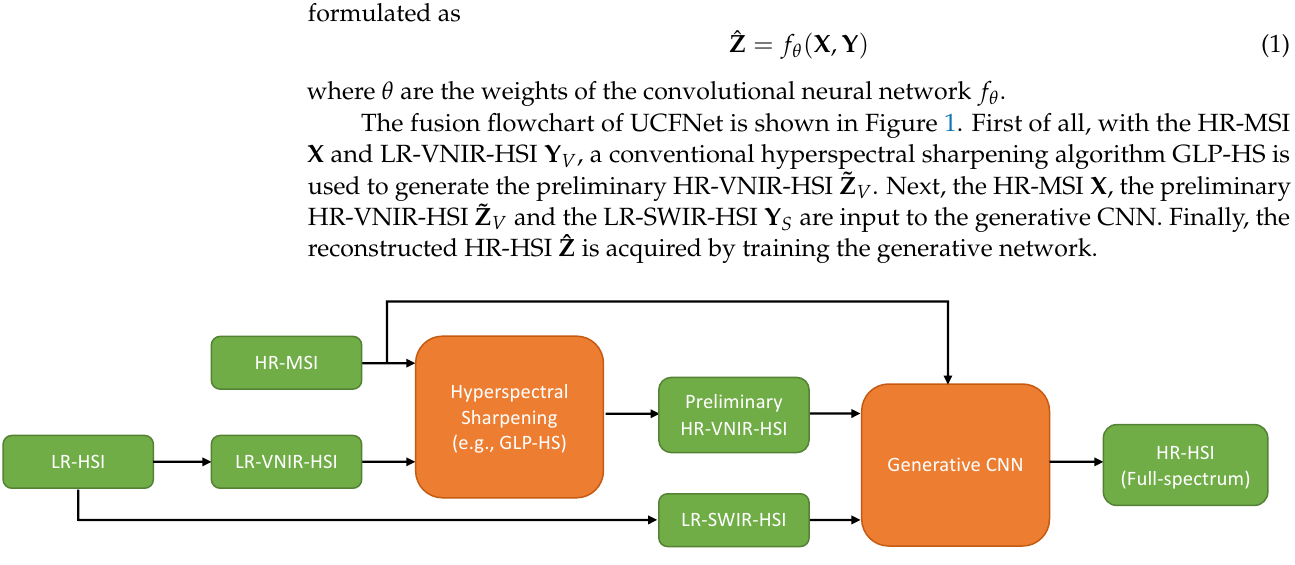
Figure 1. The image fusion diagram of